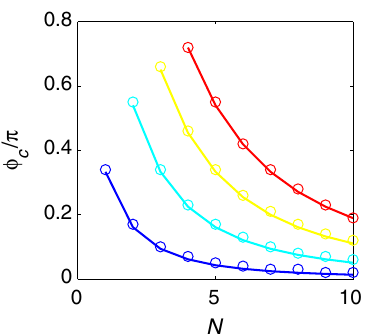
obtained by (a) numerically solving the tight-binding model Hamiltonian in Eq. (6) with cladding region width of 10 a on each side and (b) waveguide theory calculation.